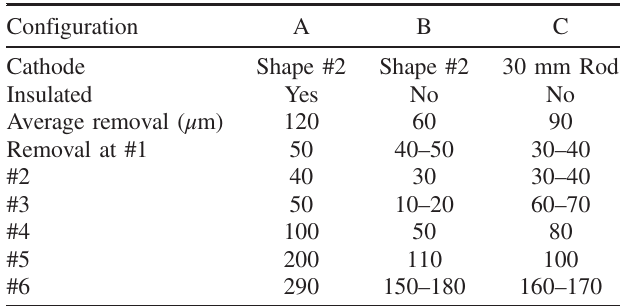
TABLE II. Measured material removal at six locations